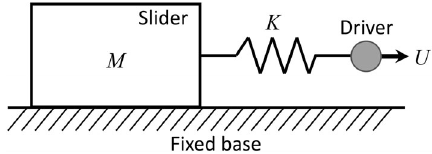
Fig. 8 One-degree-of-freedom spring–mass system. Reproduced with permissions from Refs. [4, 21]. Copyrights Nature, 1994, and Elsevier, 2010.